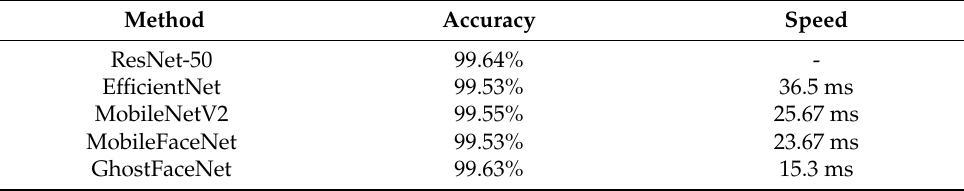
Table 12. Lightweight model performance testing in computer